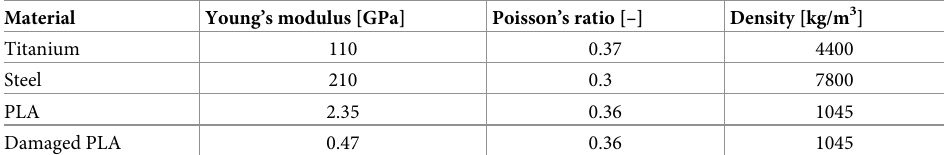
Table 1. Mechanical elastic properties.